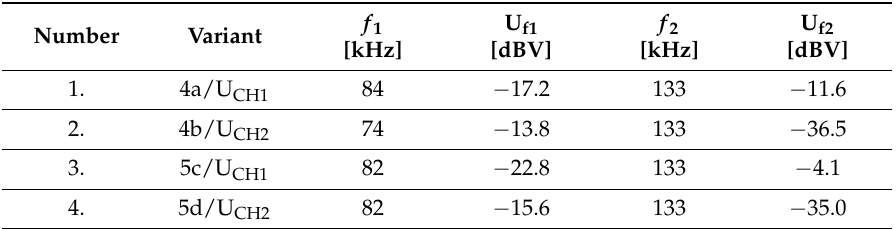
Figure 17. Voltage waveforms and voltage harmonics spectra for the various configurations of the system with the developed filter (X: 50 kHz/div and Y: 10 dB/div). System status: T PLC : broadcast ON; R PLC : ON, measured/analyzed voltages U CH1 and U CH2 ; measured frequency signal level f 1 is the intersection of the black lines and the measured frequency signal level f 2 is the intersection of the red lines. Table 2. List of the signal level measurements for the frequency f 2 = 133 kHz and for the highest disturbance components f 1